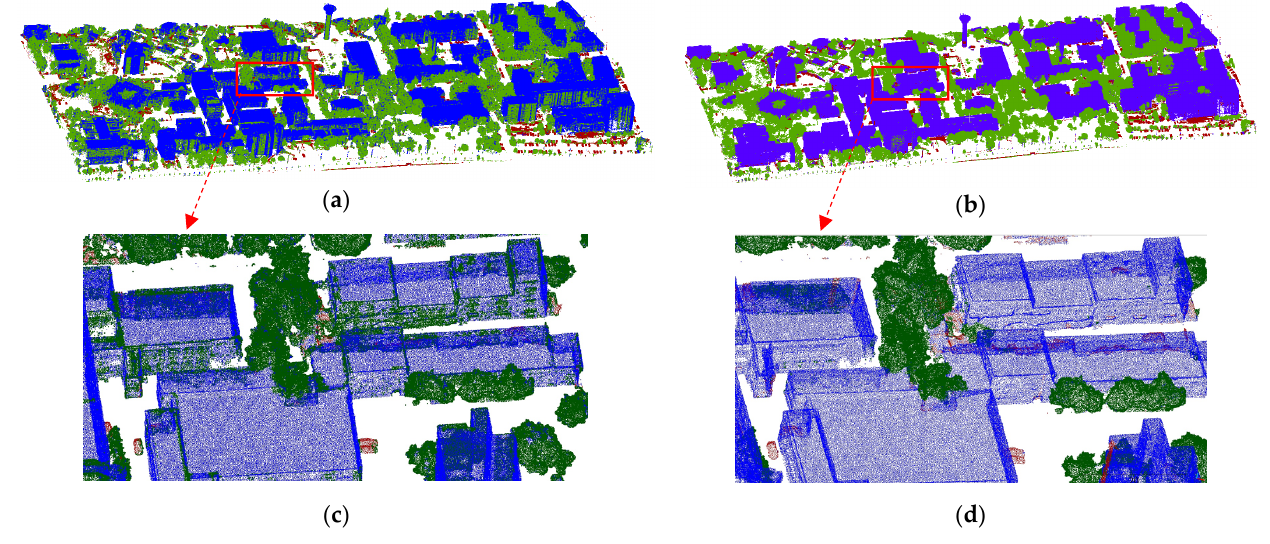
Figure 21. The classification result ( a ) with 30 attributes and ( b ) with 30 attributes and VDVI, ( c , d ) details